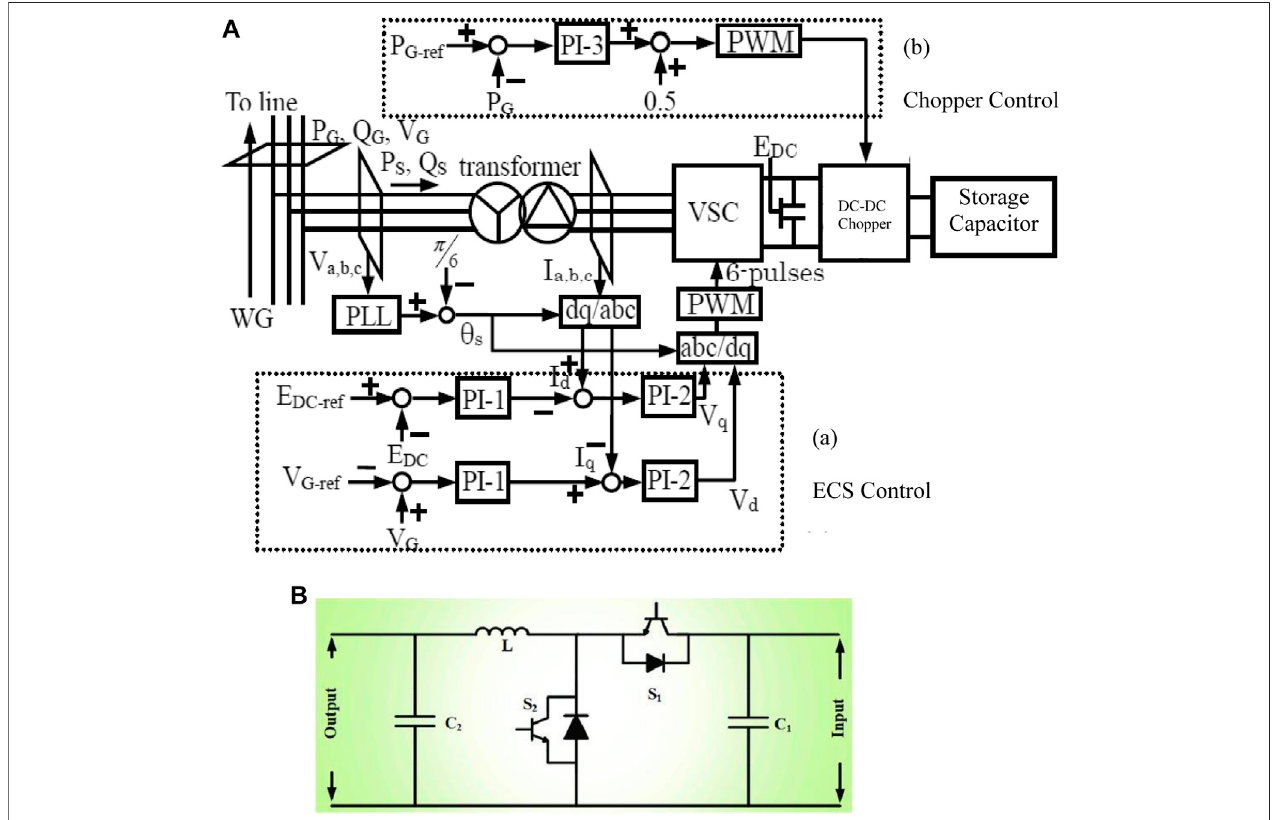
FIGURE 4 | Control strategies of the energy capacitor system and chopper circuitry. (A) Energy capacitor system. (B) Structure of the dc-dc converter.